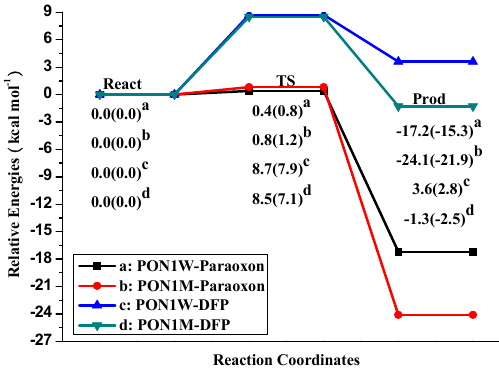
Figure 5. Potential energy profiles of the catalytic reactions for (a) PON1W-Paraoxon, (b) PON1M-Paraoxon, (c) PON1W-DFP, and (d) PON1M-DFP models with and without (in parenthesis) the solvation correction.